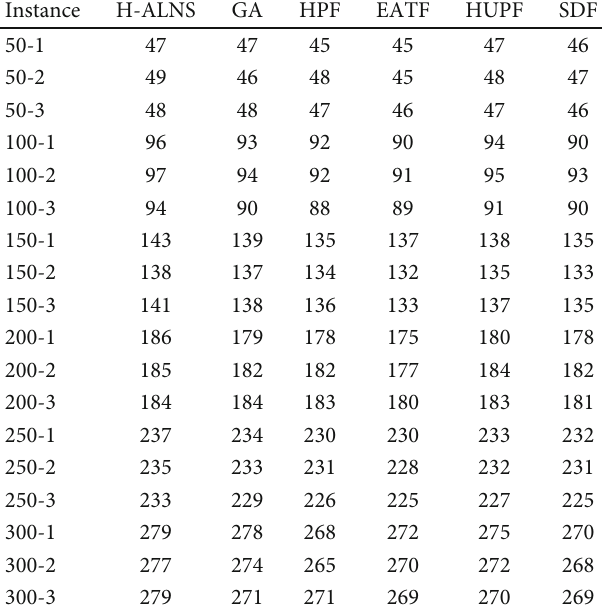
Table 6: Task completion